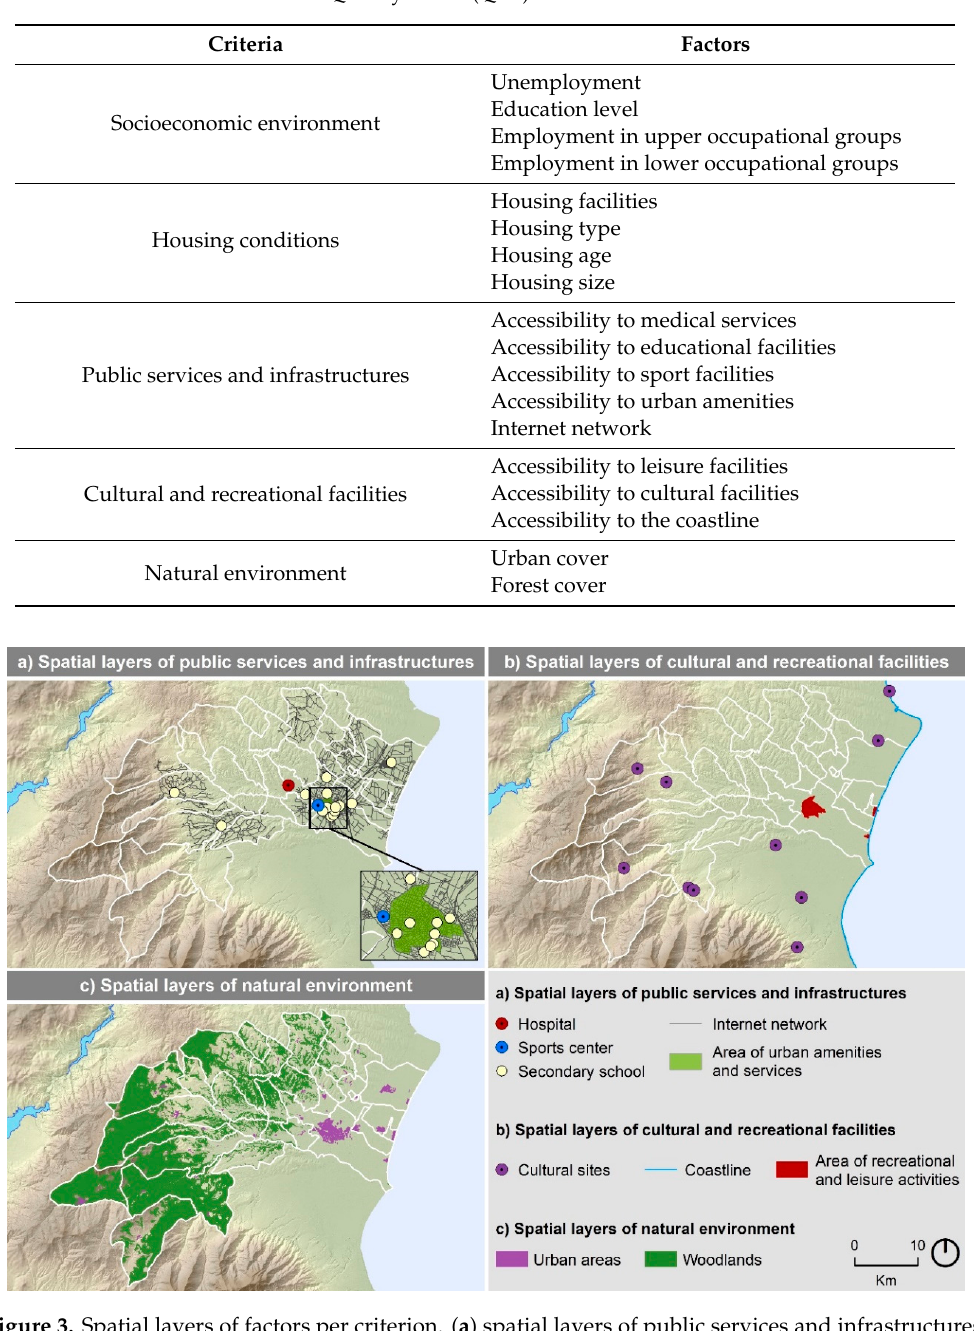
Table 2. Quality of life (QoL) criteria and factors.